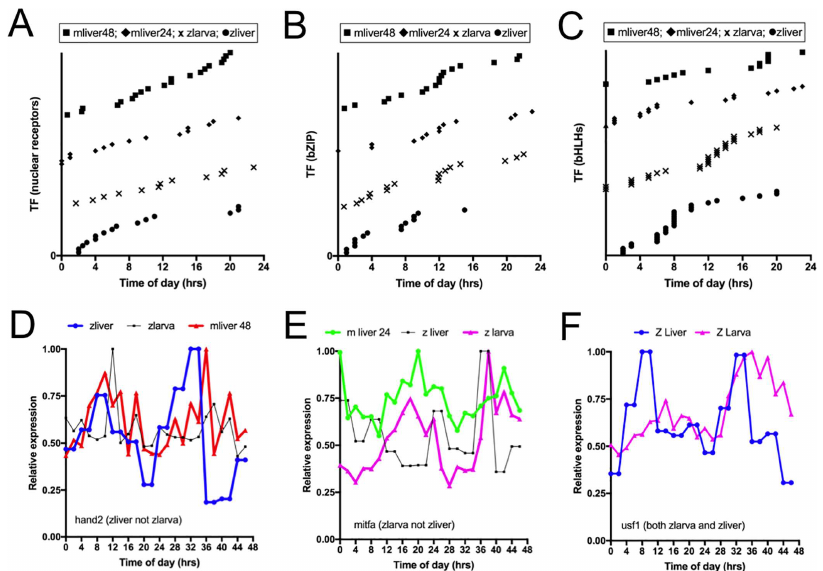
Fig 5. E box, D box and RRE regulator phases in mouse liver and Zebrafish tissues. (A) Phase of rhythmic nuclearreceptor transcripts expressedin the mouse liver. 1hr samplingrate time course: mliver48, 2hr samplingrate mouse liver time course: mliver24,Zebrafish larval and liver time courses: zlarva and zliver. (B) Phase of rhythmic bZIP transcripts expressedin same datasets as Fig 5A. (C) Phase of rhythmic bHLH transcripts expressedin same datasets as Fig 5A. (D) hand2 transcript profile in mouse liver and Zebrafish liver and larva. (E) mitfa transcript profile in mouse liver and Zebrafish liver and larva. (F) usf1 transcript profile in Zebrafish liver and